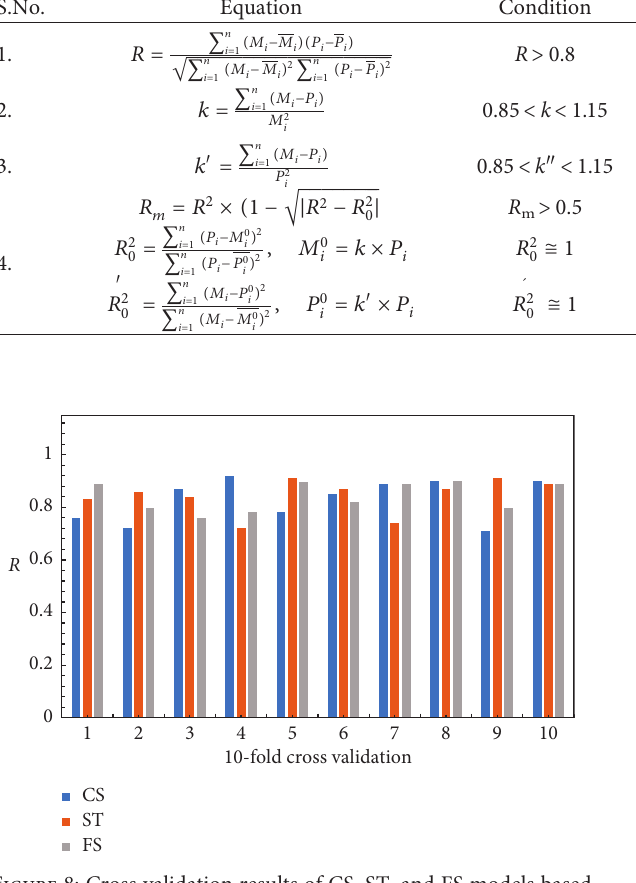
Figure 8: Cross validation results of CS, ST, and FS models based on R .